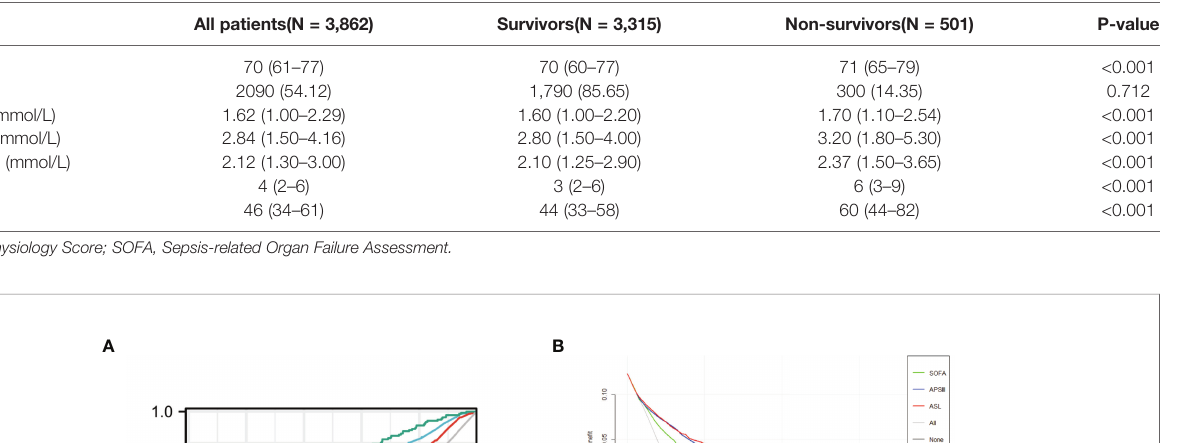
TABLE 3 | Baseline characteristics of the survivors and non-survivors in eICU cohort.